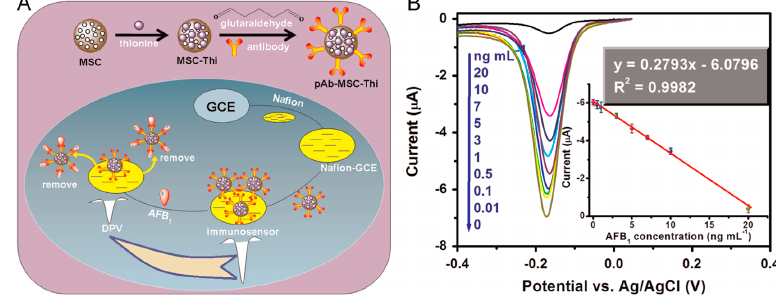
( A ) Schematic illustration of competitive-type immunosensing strategy, based on target-induced displacement reaction between thionine-decorated mesoporous carbon nanospheres bearing the antibody (pAb-MSC-Thi) and an Nafion-modified glassy carbon electrode (Nafion-GCE) for the electrochemical detection of aflatoxin B 1 (AFB 1 ). ( B ) Differential pulse voltammograms recorded for the immunoassay toward increasing AFB 1 concentrations (reproduced from